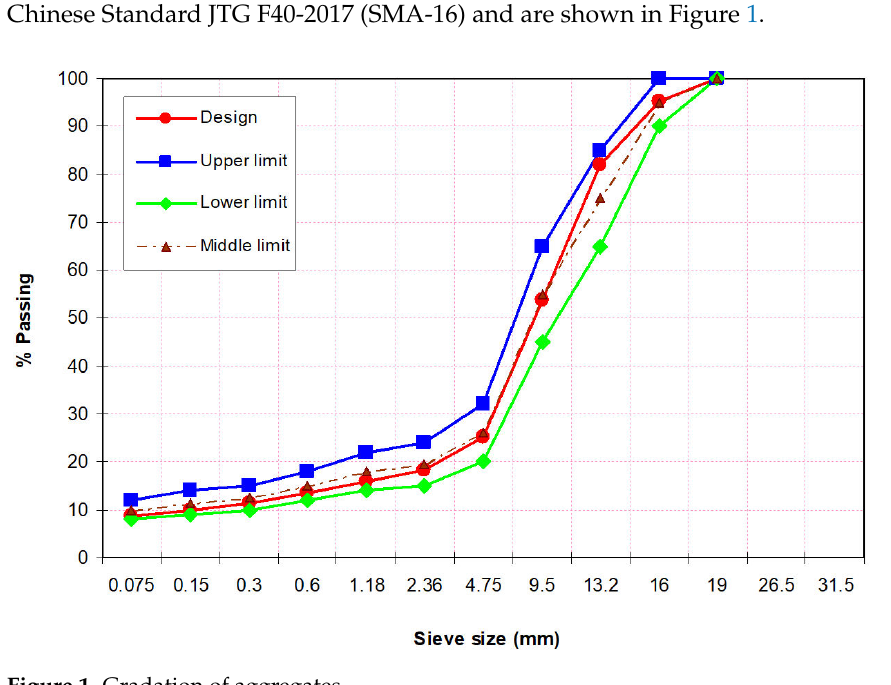
Figure 1. Gradation of